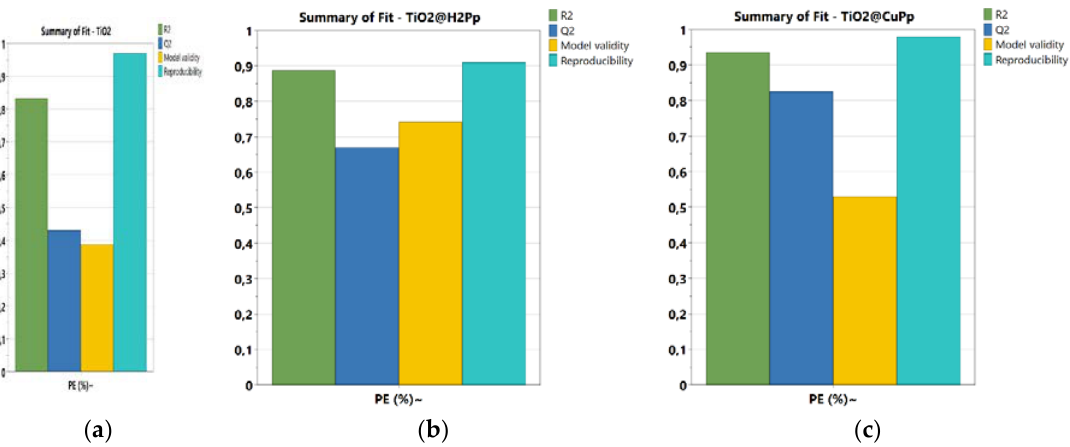
Figure 5. Summary plots obtained for ( a ) TiO 2 , ( b ) TiO 2 @H 2 Pp, and ( c ) TiO 2 @Cu(II)Pp catalysts. Parameters are shown as follows: R 2 : green bar; Q 2 : blue bar; Model validity: yellow bar; Reproducibility: light blue bar.